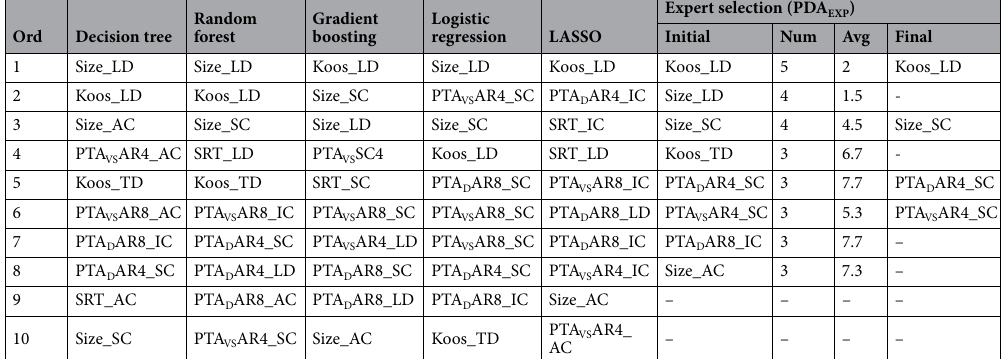
Table 7. Predictors, extracted from PDA data set, ordered according to their significance for each dimensionality reduction method. Irrelevant variables were rejected from expert selection. Variables and metrics are expressed as follows (see “Methods”): (a) suffix 4 holds for the basic frequency range, suffix 8 holds for the full frequency range; (b) subscripts H and VS hold for the healthy or diseased ear, respectively, subscript D holds for the difference of averaged PTA values between the two ears; (c) tailing abbreviations have the following meaning: AR average row wise, IR intercept row wise, SR slope row wise, AC average column wise, IC intercept column wise, SC slope column wise, LD last difference, TD total difference.